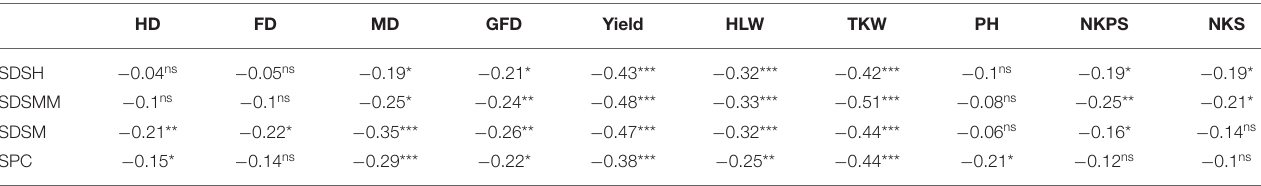
TABLE 6 | Correlation analyses among Septoria resistance traits and some agronomic traits in 180 bread wheat genotypes based on the pooled data from 2 years of field trials in Ethiopia.